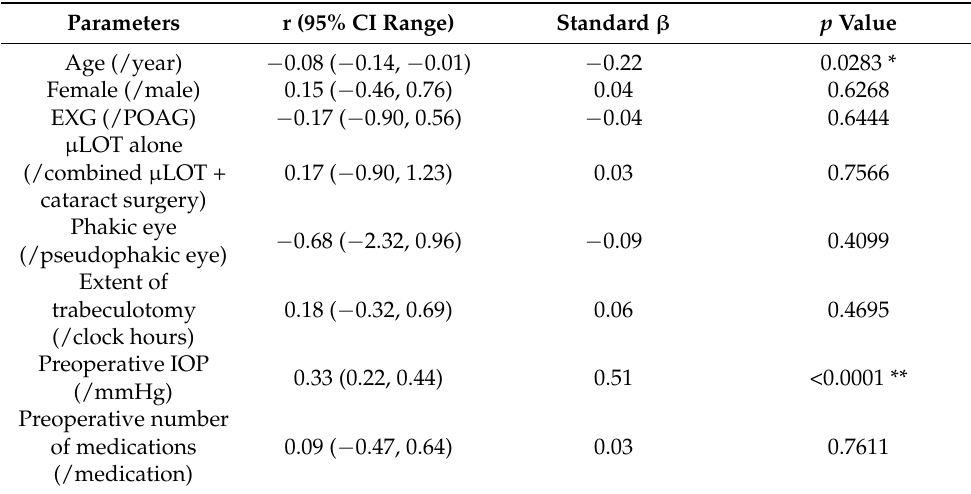
Table 4. Assessment of factors associated with postoperative intraocular pressure